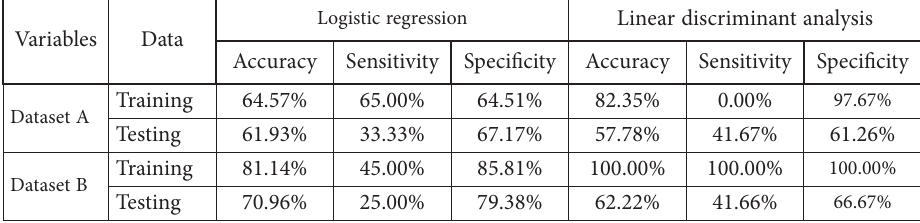
Figure 1. Density plot with both a) “without financial restatement” (group 0) and b) “with financial restatement” (group 1) Table 8. Comparison of performance for logistic regression and linear discriminant analysis